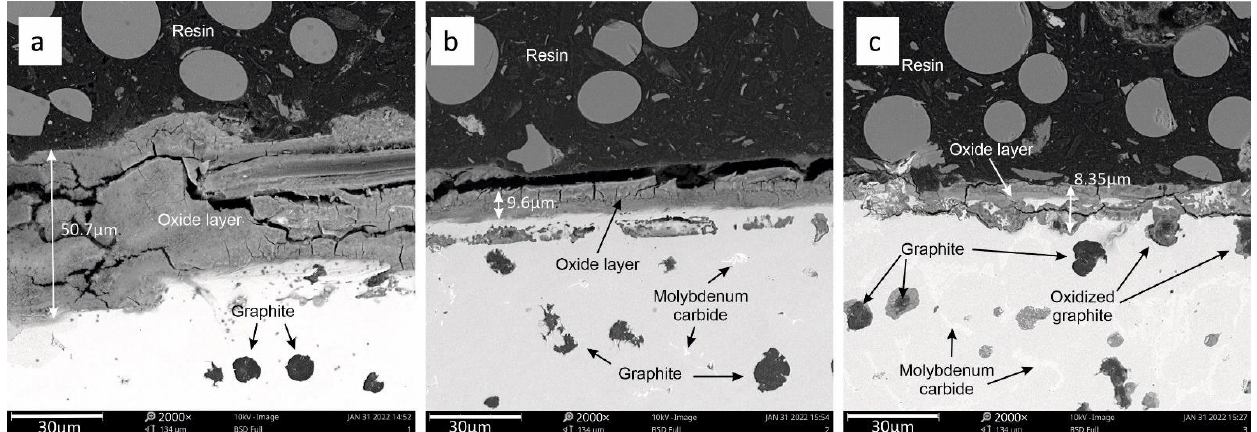
Figure 12. Thickness of the oxide layer for the samples under analysis. Sample 1 ( a ), sample 2 ( b ), sample 3 ( c ).